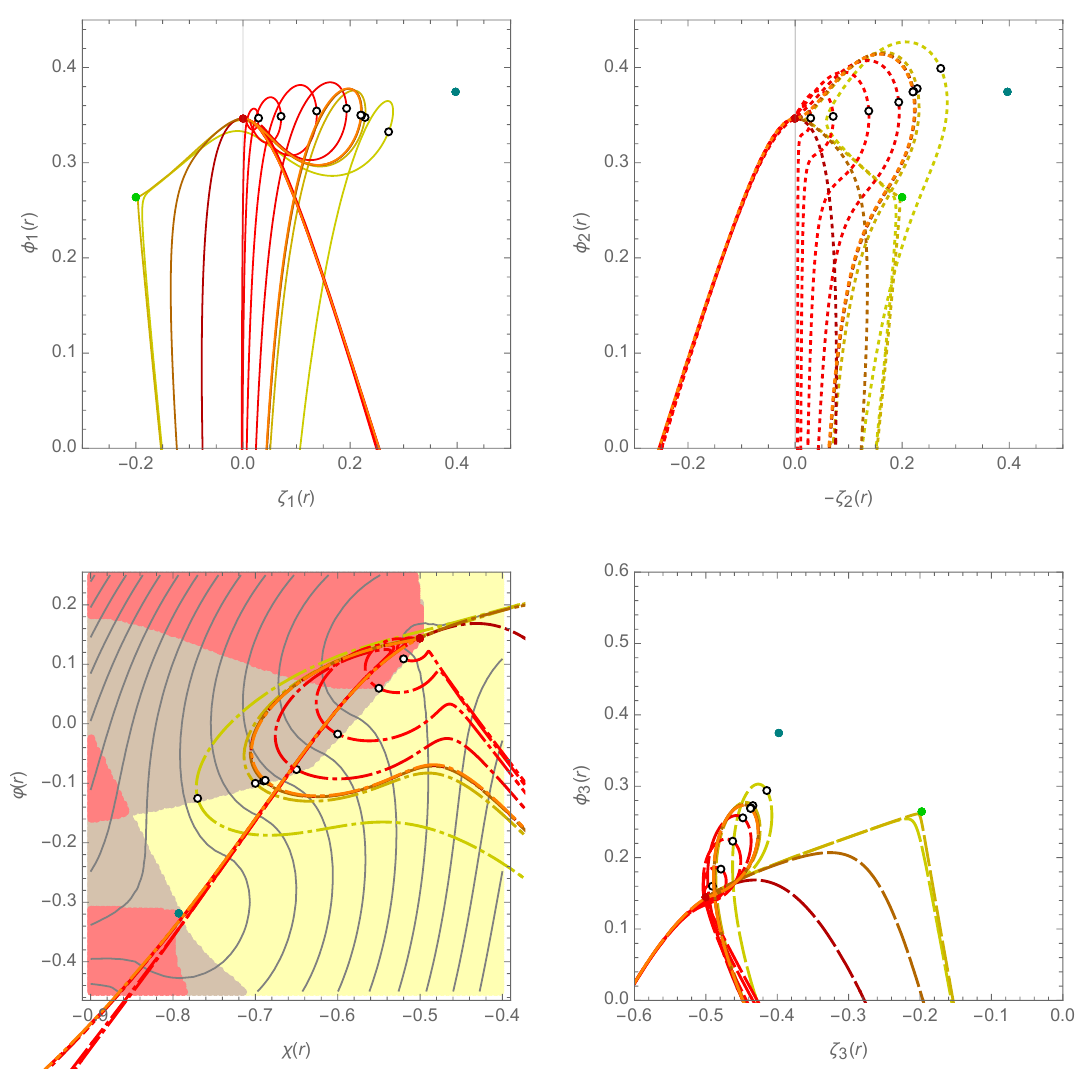
Figure 22. Space of N = 1 Janus solutions with SO(3) symmetry and turning points on the boundary between yellow and grey regions toward the U(3) critical